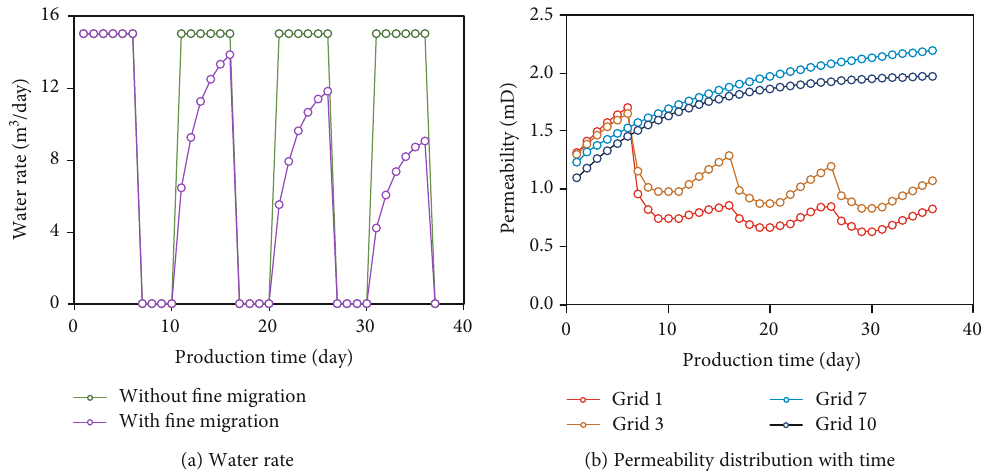
Figure 10: The e ff ect of multiple well shut on early water drainage.